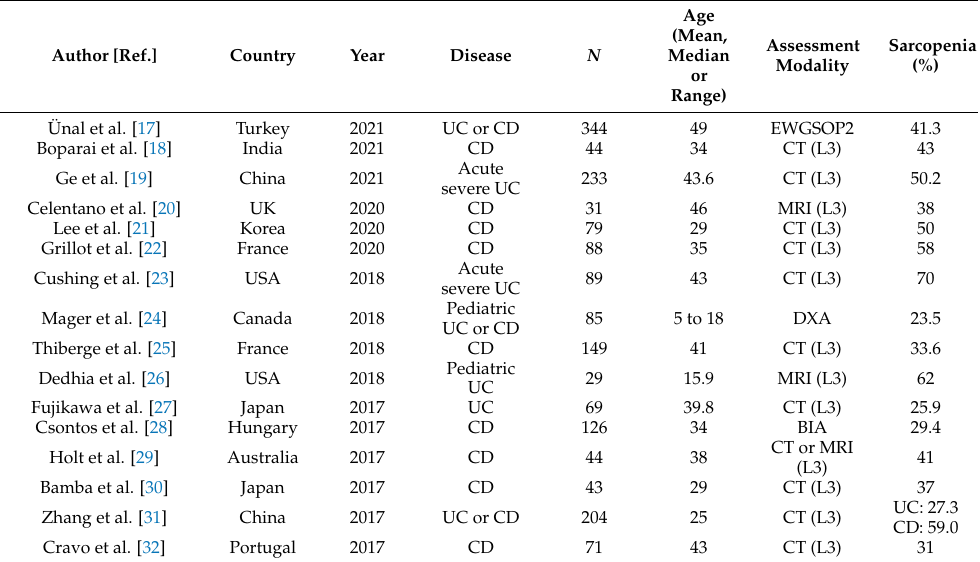
Table 1. Prevalence of sarcopenia in adult or pediatric patients with inflammatory bowel diseases reported in recent